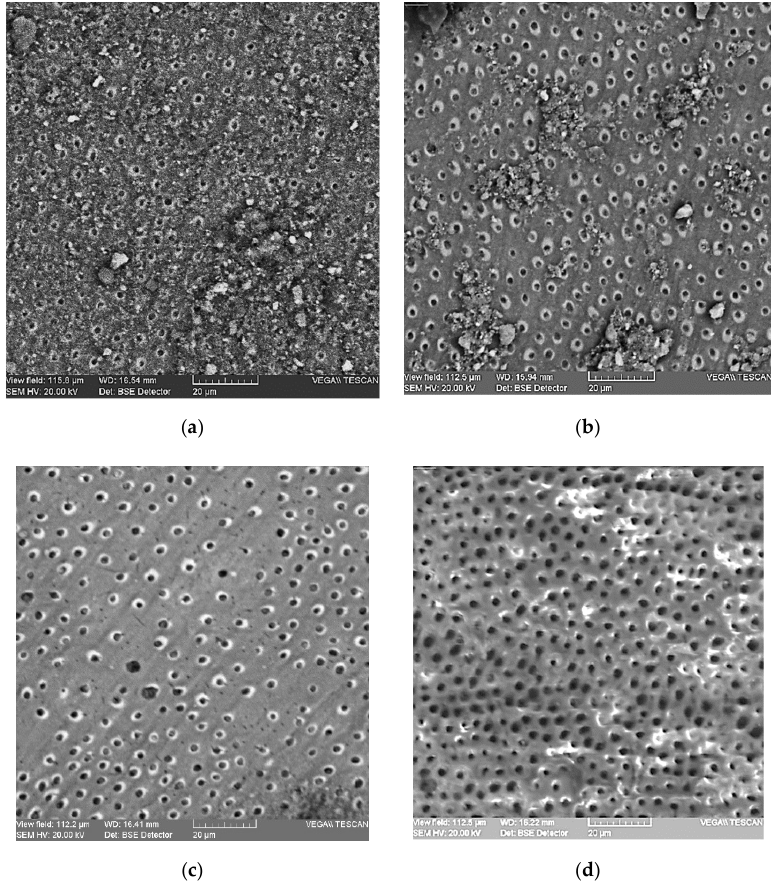
Figure 1. SEM micrographs of dentin samples in study groups ( a – c ) and control group ( d ). ( a ) SEM image (2000×) of a dentin sample in group 1 (score 1). ( b ) SEM image (2000×) of a dentin sample in group 2 (score 1). ( c ) SEM image (2000×) of a dentin sample in group 3 (score 2). ( d ) SEM image (2000×) of a dentin sample in group 4 (score 5). SEM images on the dentin surface showing dentinal tubule occlusion with di ff erent scores in the study groups (group 1: Karex toothpaste, group 2: Biorepair Plus Sensitive toothpaste, and group 3: Dr. Wol ff ’s Biorepair toothpaste) and in the control group (group